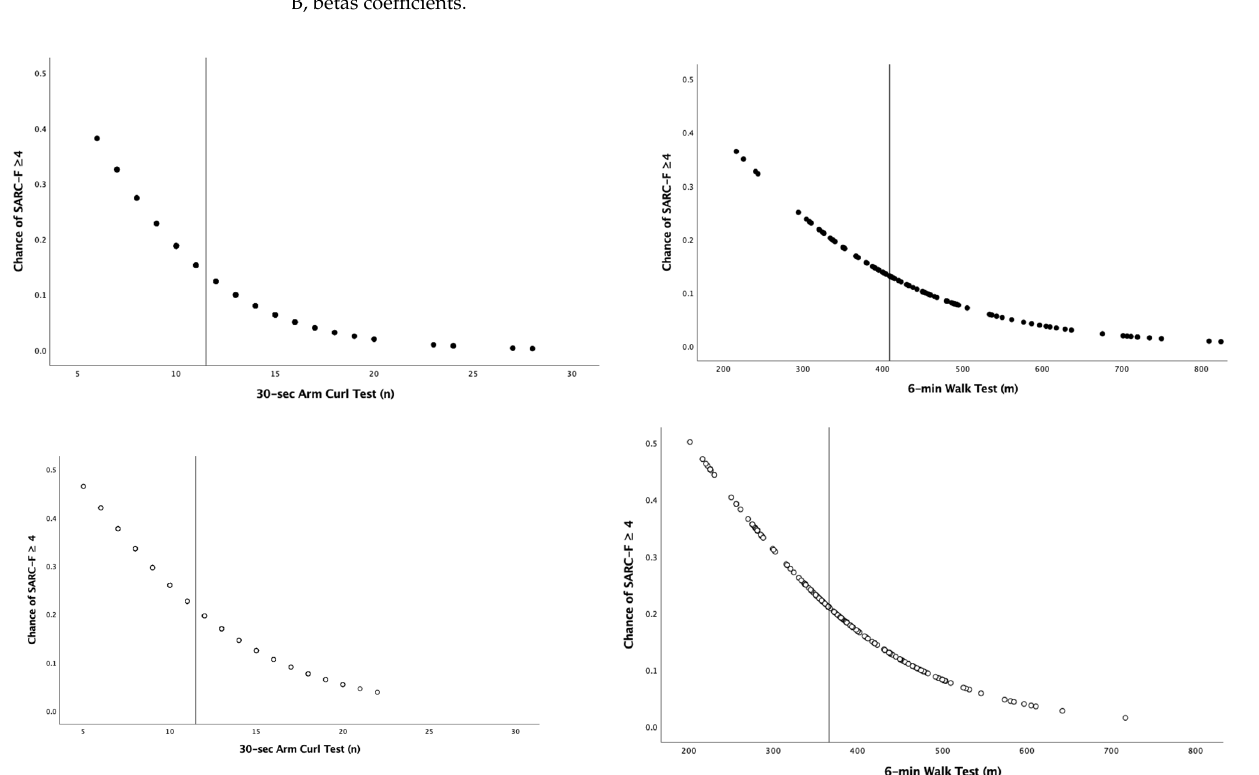
Table 4. Associations through logistic regression between the occurrence of each sarcopenia symptom based on the participants’ physical fitness.